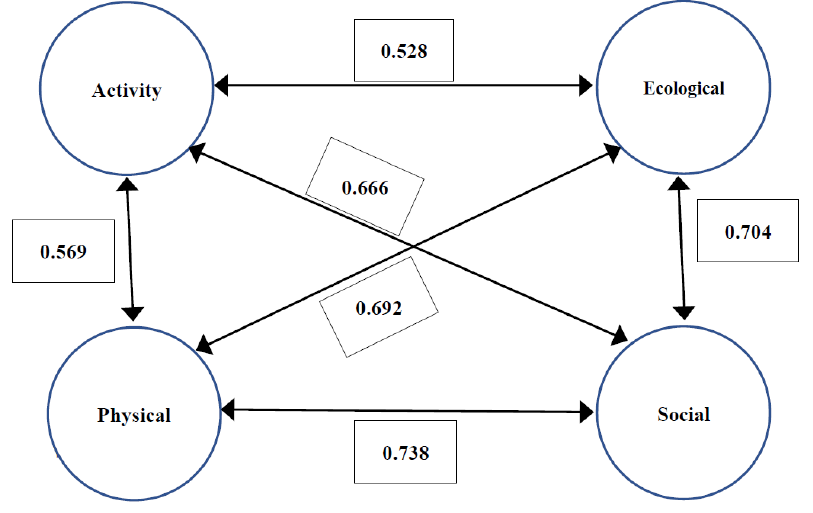
Figure 5. The relations between environmental quality constructs affecting users’ mental well-being.